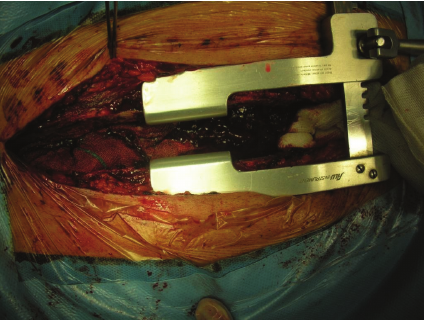
Figure 3: Mediastinal